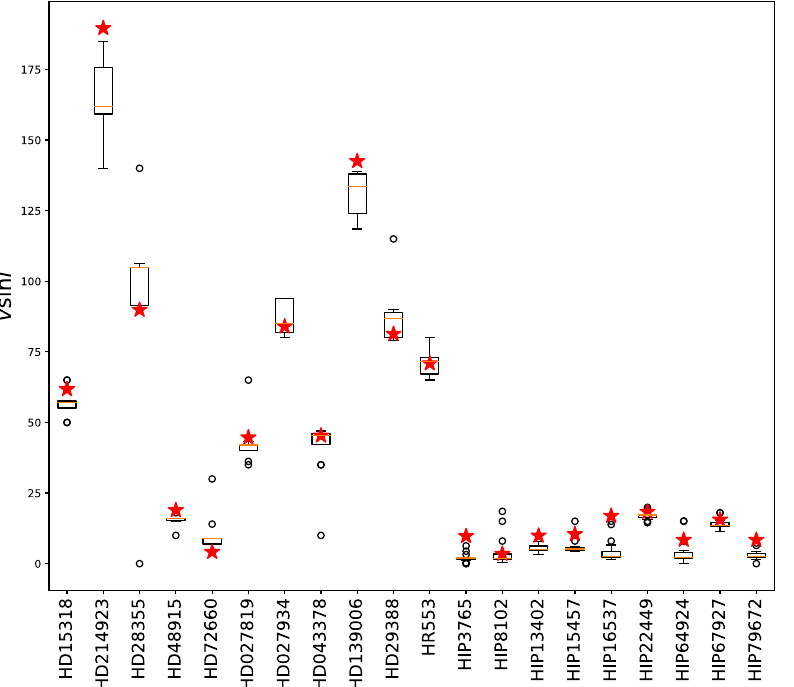
Figure 7: Same as Figure 4 but for v i sin e .